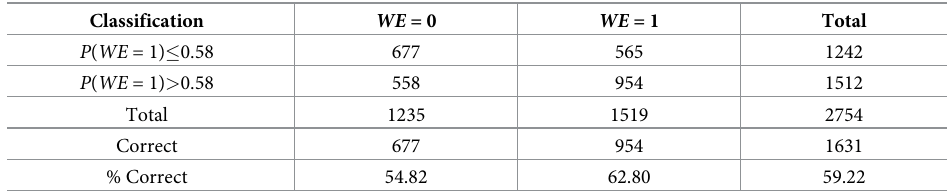
Table 4. ARN: Predicted-observed